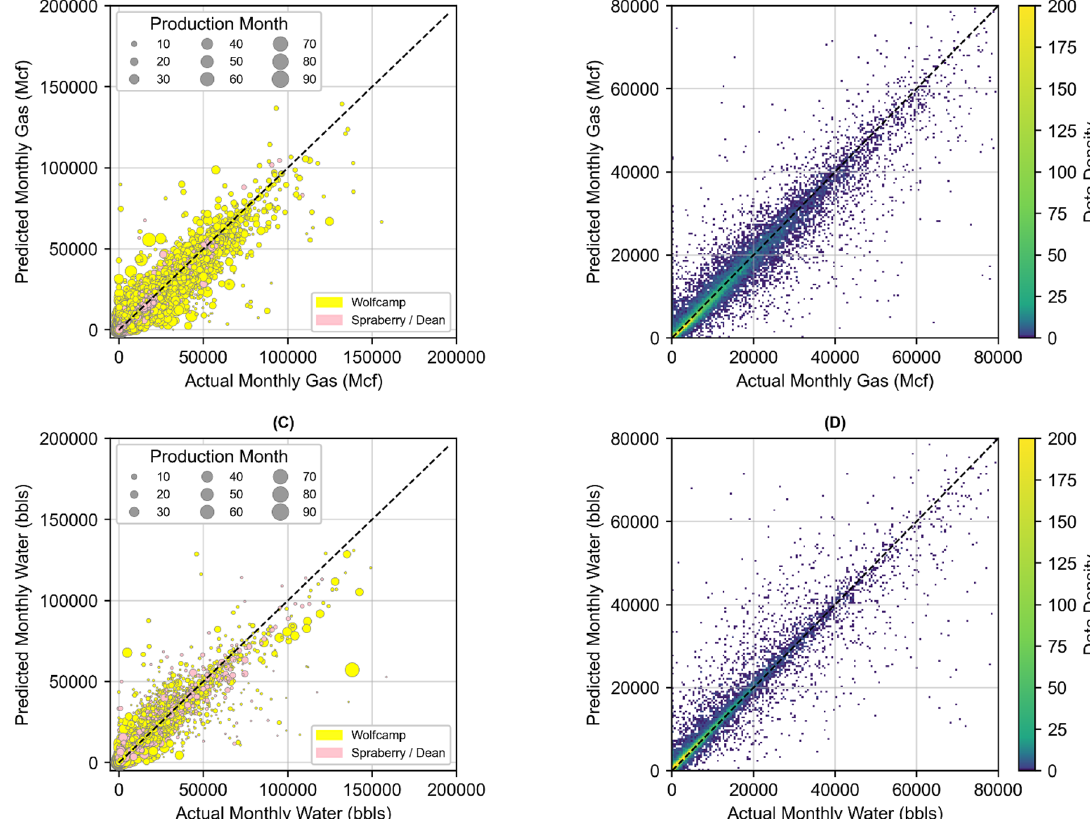
Figure 10. Parity plots of model performance comparing predicted values for monthly gas ( A ) or water ( C ) against actual values (i.e., observations) for wells in the test dataset. Additionally, the density of data within plot area pixels is provided for gas ( B ) and water ( D ). Density plots zoom to focus on the 0 to 80,000 bbls or Mcf fluid volume range where the majority of test data occurs.